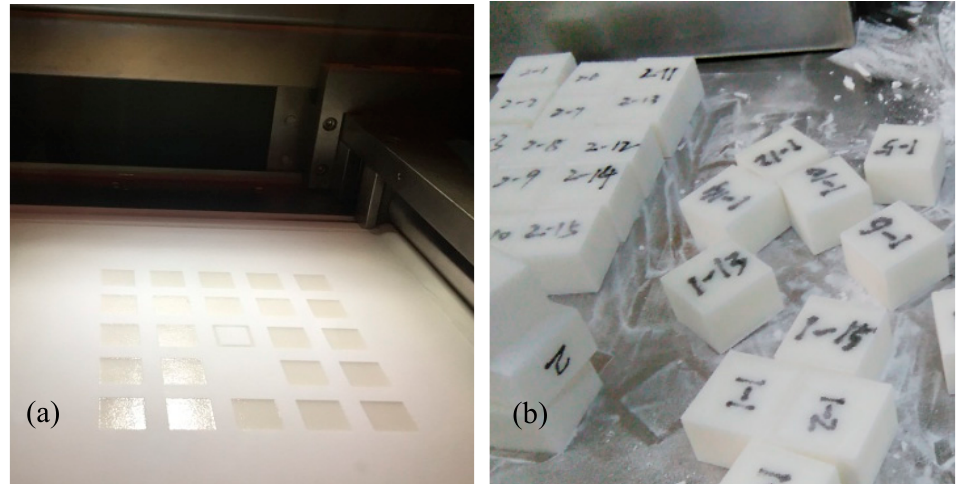
Figure 8. Statistical sintering experiment: ( a ) SLS molding process for the statistical box; ( b ) powder cleaning of sintered parts in the statistics box.